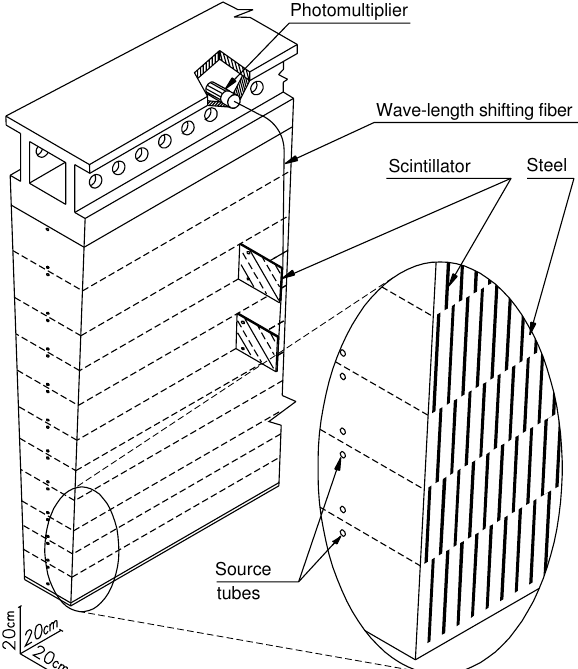
Figure 1. A schema of the mechanical assembly and optical readout of one Tile Calorimeter module. Each module consists of 11 radial rows of tiles of different sizes that are grouped into 3 radial readout layers (3-6-2 rows of tiles in the Long Barrel, 3-4-4 rows of tiles in the Extended Barrels). The pseudo- projective cell geometry in pseudorapidity is achieved by grouping the corresponding WLS fibers onto one